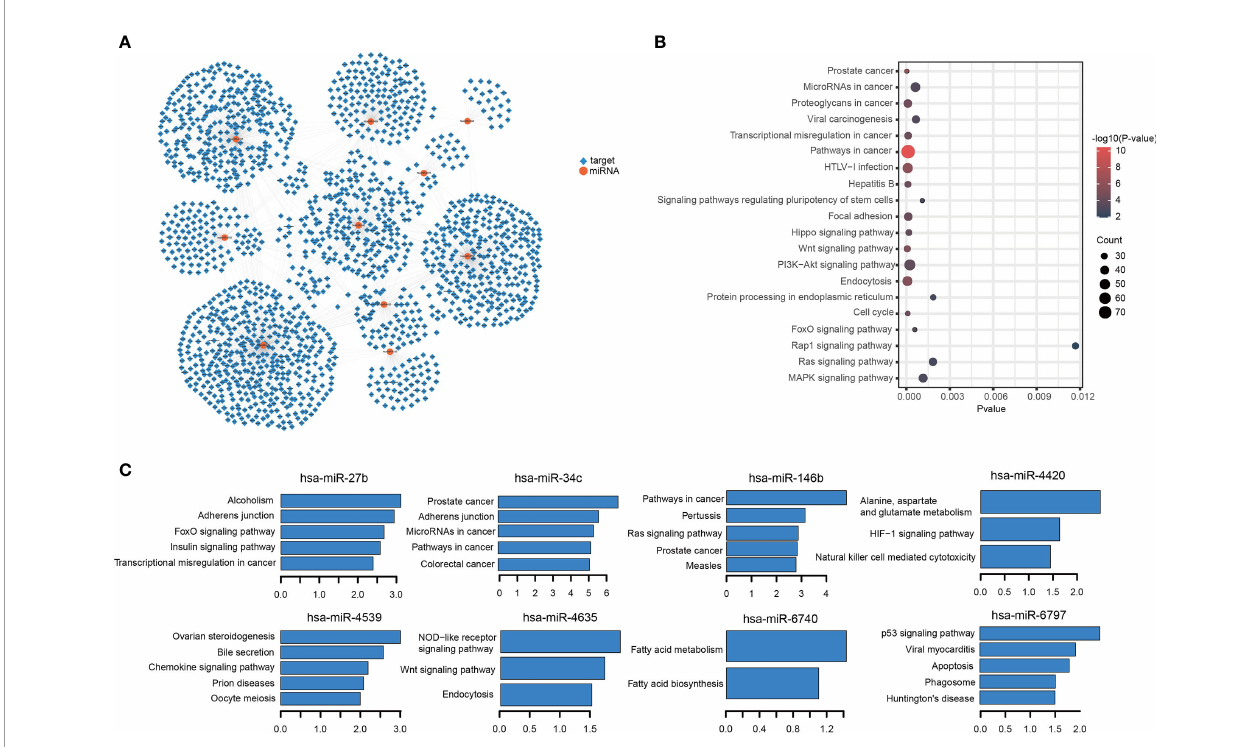
FIGURE 5 | miRNAs-targets network and KEGG enrichment analysis. (A) miRNAs-targets network. Circular node denotes miRNAs, square node denotes targets. (B, C) Results for KEGG enrichment